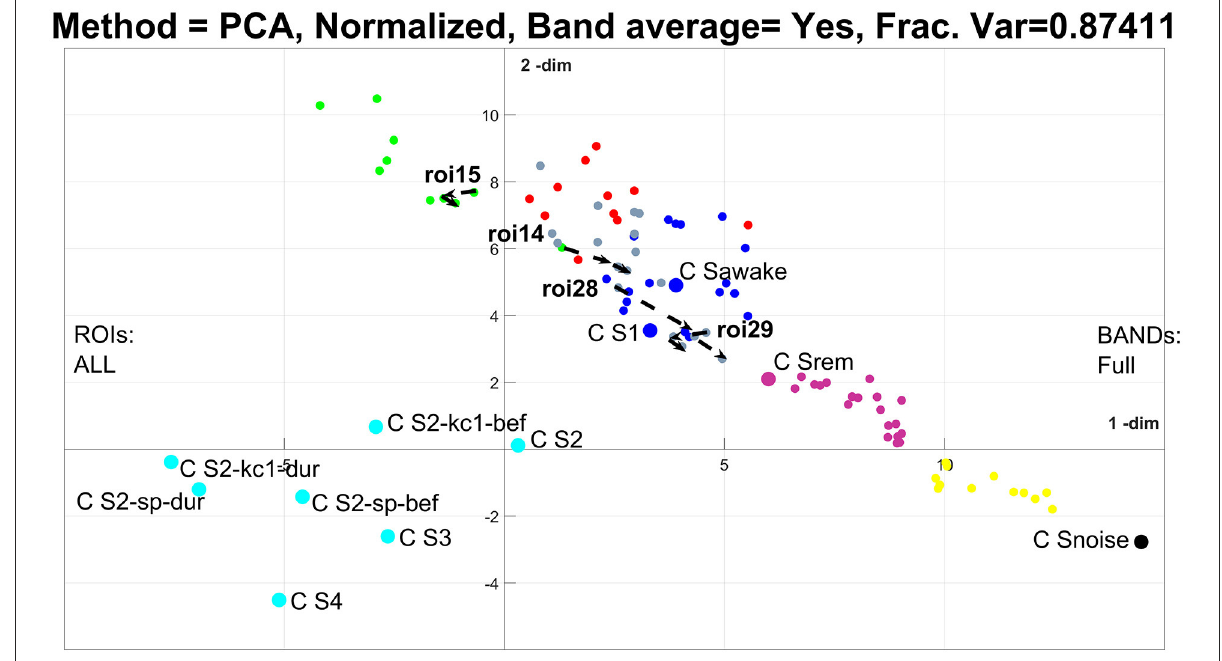
FIGURE4 The results of PCA analysis using the un-united region of interest (ROI) resolution in the plane defined by the first two PCA. Exactly the same data are used as in the previous figure, and the same analysis, except that in collapsing the centers, each sleep stage, including REM, is represented by a single representative node (CENTER). The three nodes representing the transition from ECW to NREM1 in figure are now represented by 87 nodes and the single transition in Figure 3 is now represented by four paths, one for each V1 and FG in each